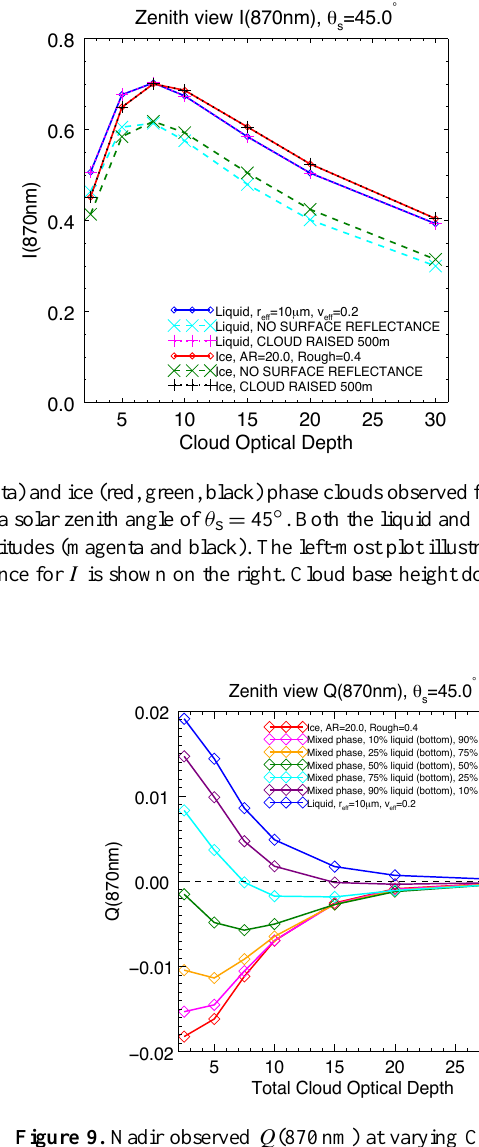
Figure 9. Nadir observed Q (870nm) at varying CODs for an ice phase cloud (red), liquid phase cloud (blue), and mixed-phased clouds. The mixed-phase clouds have the liquid phase on the bot- tom and ice on the top, mixed in percentages of total COD. The simulated solar zenith angle was θ s = 45 ◦